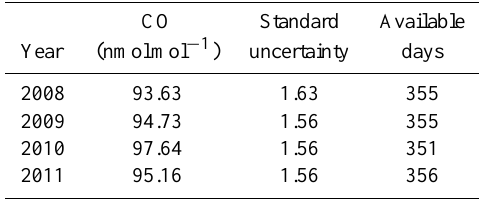
Fig. 7. Autocorrelation of the residuals from the fit determined from Eq. (26). Table 6. Annual mean and the standard uncertainty of nighttime (20:00–08:00UTC) CO mole fractions (in nmolmol − 1 ) measured between 2008 and 2011, and number of days with data available.